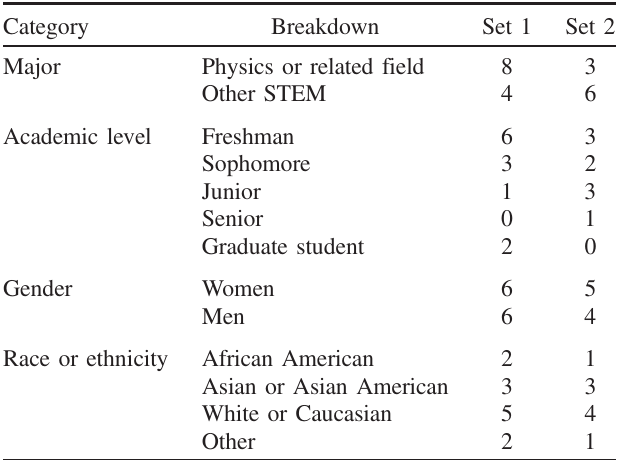
TABLE IV. Demographic breakdown of students interviewed to probe the validity of the closed-response